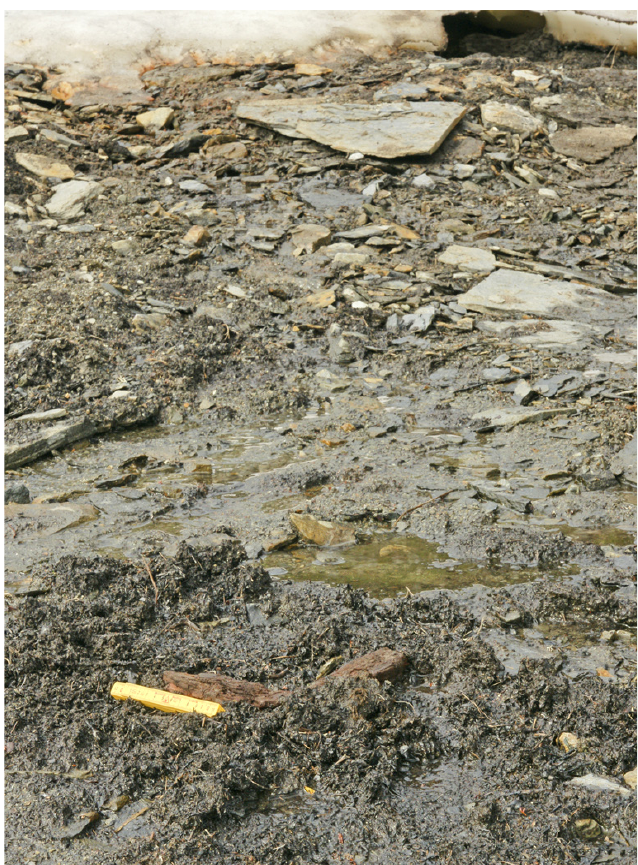
Figure 20: Låktatjåkka (12). Basal part of a small birch tree, obviously preserved in situ. 5800 cal. yr BP (Beta-284472).